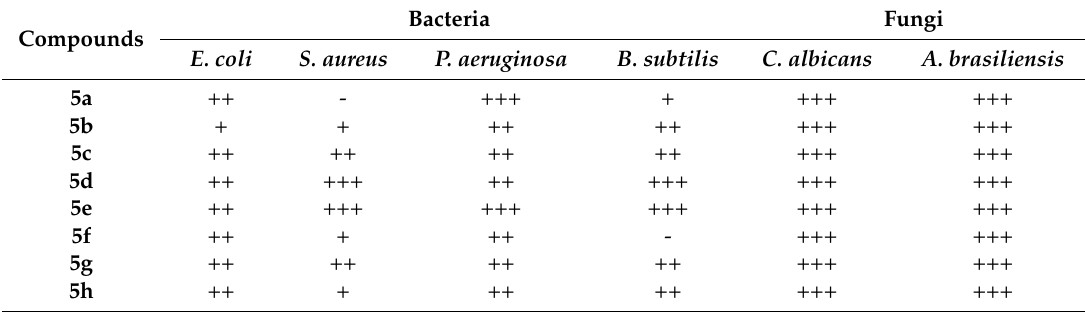
Table 3. Antimicrobial activity data of the synthesized compounds 5a – h , determined by the agar diffusion method.